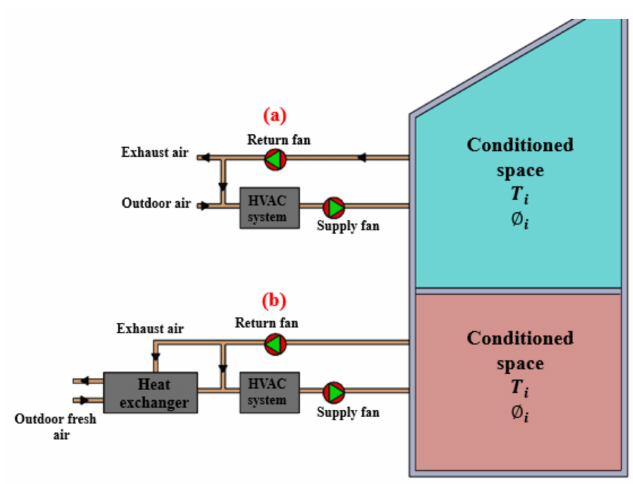
Figure 1. ( a ) All-air HVAC system illustration, and ( b ) schematic of the HVAC system with heat